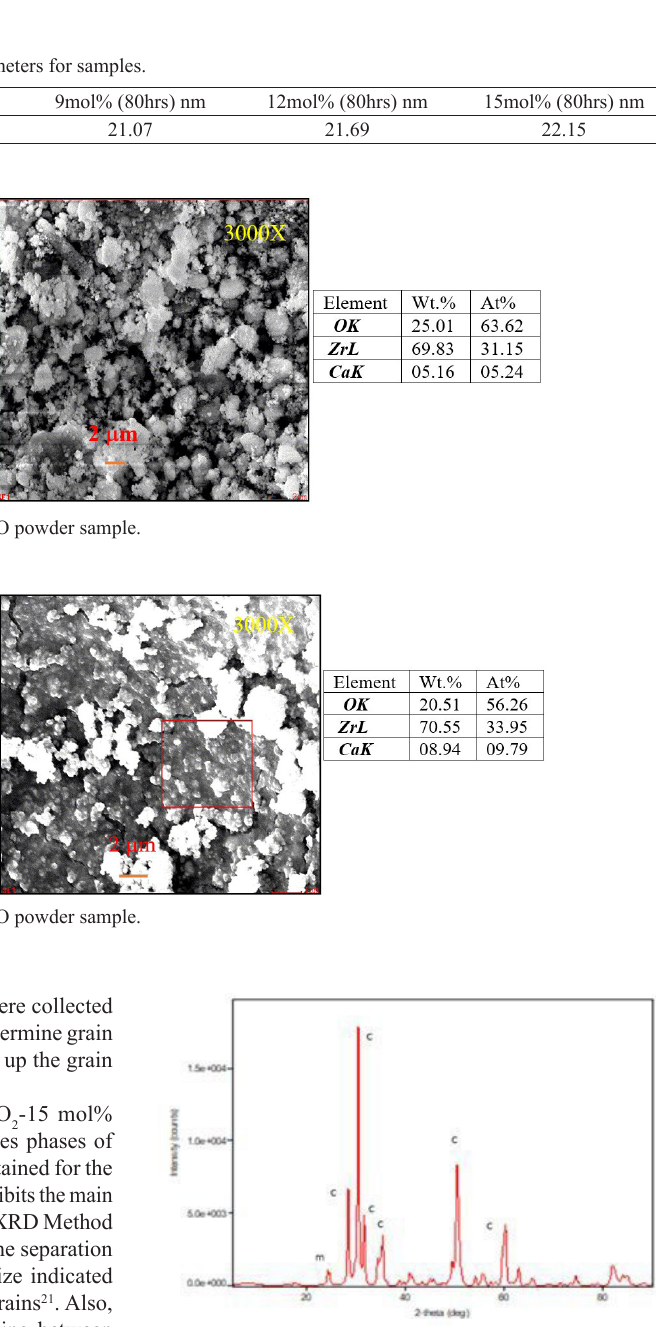
Figure 4. Calcia-stabilized zirconia powder XRD with 15 Mol% CaO for 80 hours.